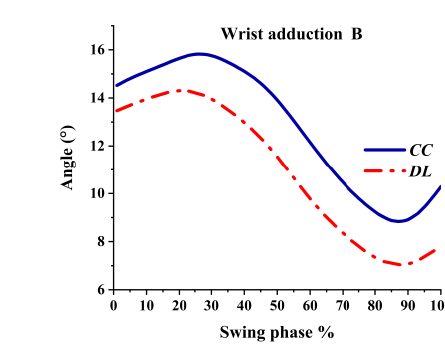
Figure 3. Wrist angles during the swing phase.